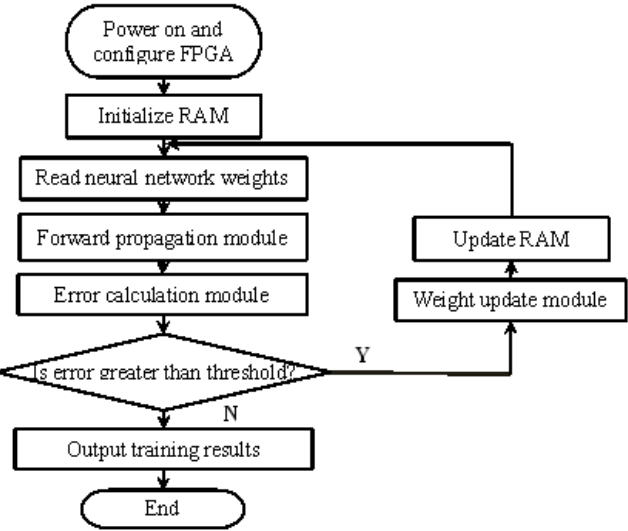
Figure 11. Flow chart of the back propagation (BP) algorithm based on the FPGA. RAM: Random Access Memory. Table 5. Training time and consumption comparison of the CPU and FPGA. CPU: Central Processing Unit; FPGA: Field Programmable Gate Array.